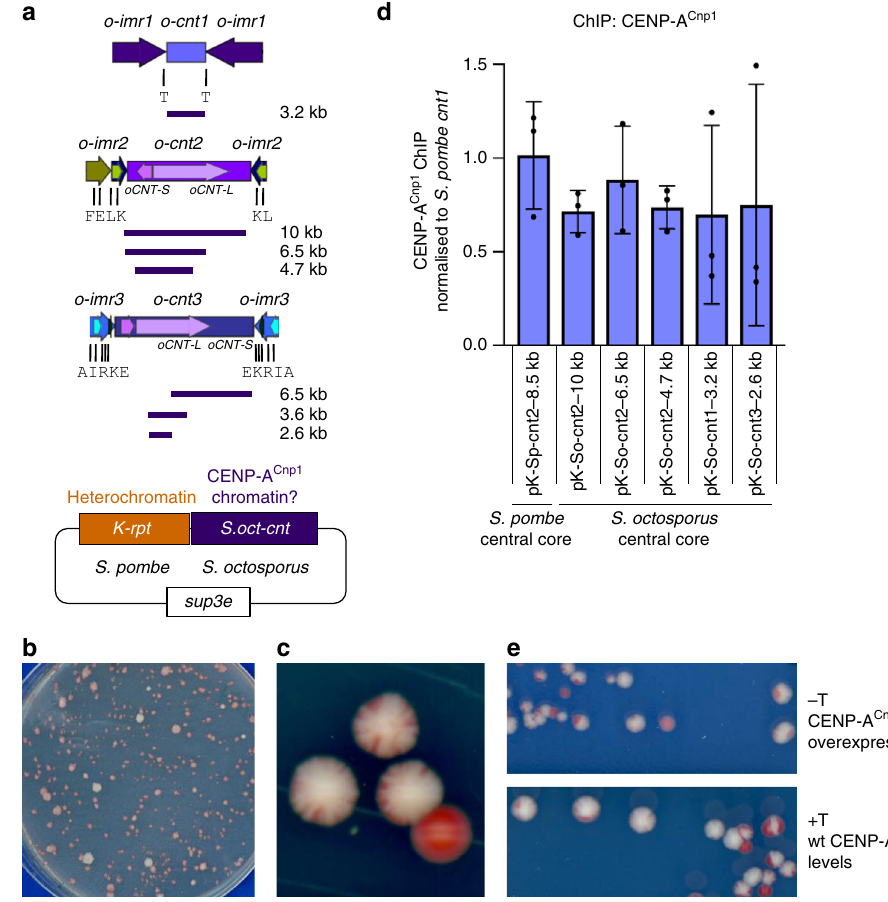
Fig. 6 S. octosporus central-core DNA establishes CENP-A Cnp1 chromatin upon introduction into S. pombe . a Indicated regions of S. octosporus central-core DNA placed adjacent to a portion of S. pombe heterochromatin-forming outer-repeat sequence on a plasmid. b S. pombe transformants containing minichromsome plasmids were replica-plated to low-adenine non-selective plates: colonies retaining the chimeric minichromosome plasmid are white/ pale pink, those that lose it are red. Representative plate showing pKp-So-cnt3-6.5kb-containing colonies. c S. pombe cells containing pKp-So-cnt3-6.5 kb chimeric minichromosome were streaked to single colonies. Red colour indicates loss of minichromosome; small red sectors indicate low-frequency minichromosome loss and mitotic segregation function. d ChIP-qPCR for CENP-A Cnp1 on S. pombe hi-CENP-A Cnp1 cells containing chimeric minichromosomes with established centromere function. Three biologically independent transformants were analysed for each minichromosome ( n = 3). ChIP enrichment on S.pom-cnt2 and S.oct-cnt -bearing minichromosomes is normalized to the level at endogenous S. pombe cnt1 . Individual data points are shown as black dots. Error bars, SD. e Propagation of chimeric minichromosome stability. Cells containing pK(5.6 kb)-So-cnt2-10 kb were streaked on low- adenine-containing plates with or without thiamine, which results in repression or expression of high levels of S. pombe CENP-A Cnp1 . Source data available as a Source Data fi adaptor sequences) were selected using Ampure XP beads (Beckman Coulter). The libraries were sequenced following Illumina HiSeq2000 work fl ow (or as indicated in Supplementary Table 11).